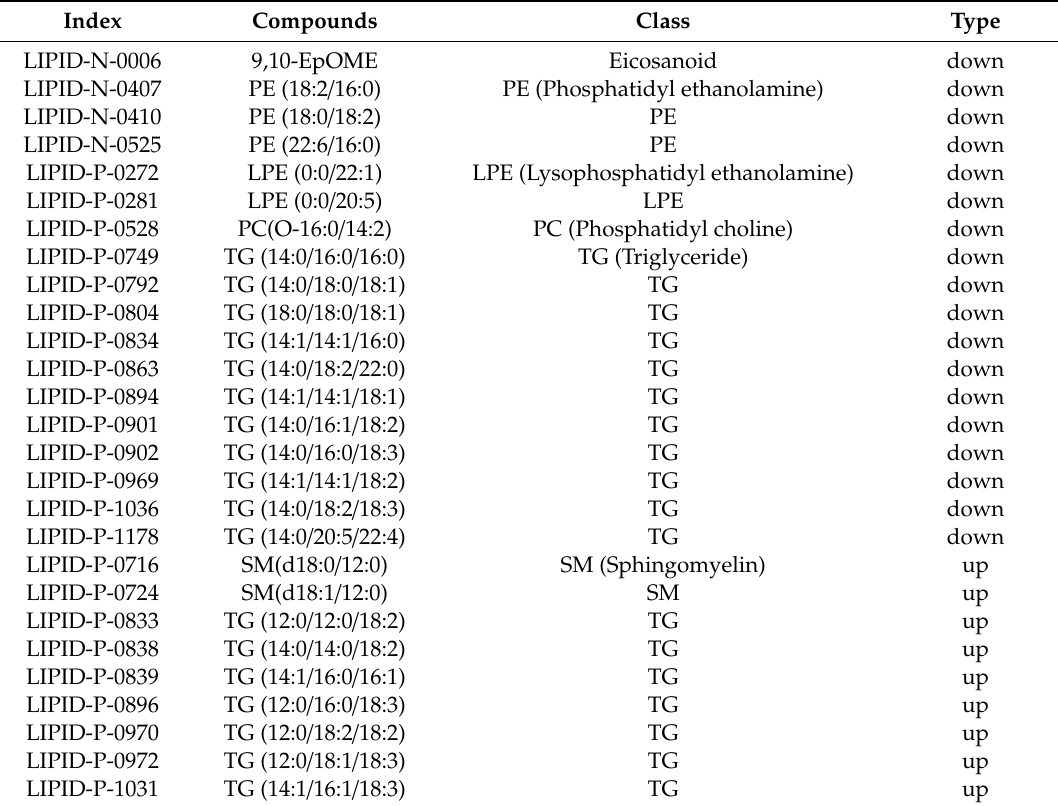
Table 3. The screening results of di ff erential